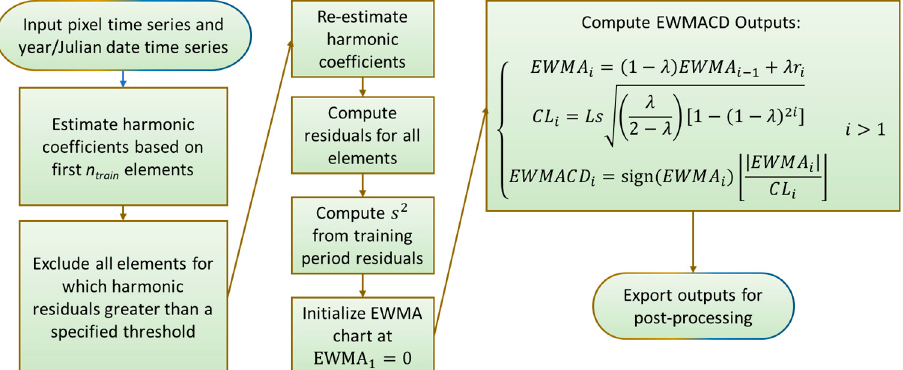
Figure 3. Core EWMACD process for a given pixel/time series.